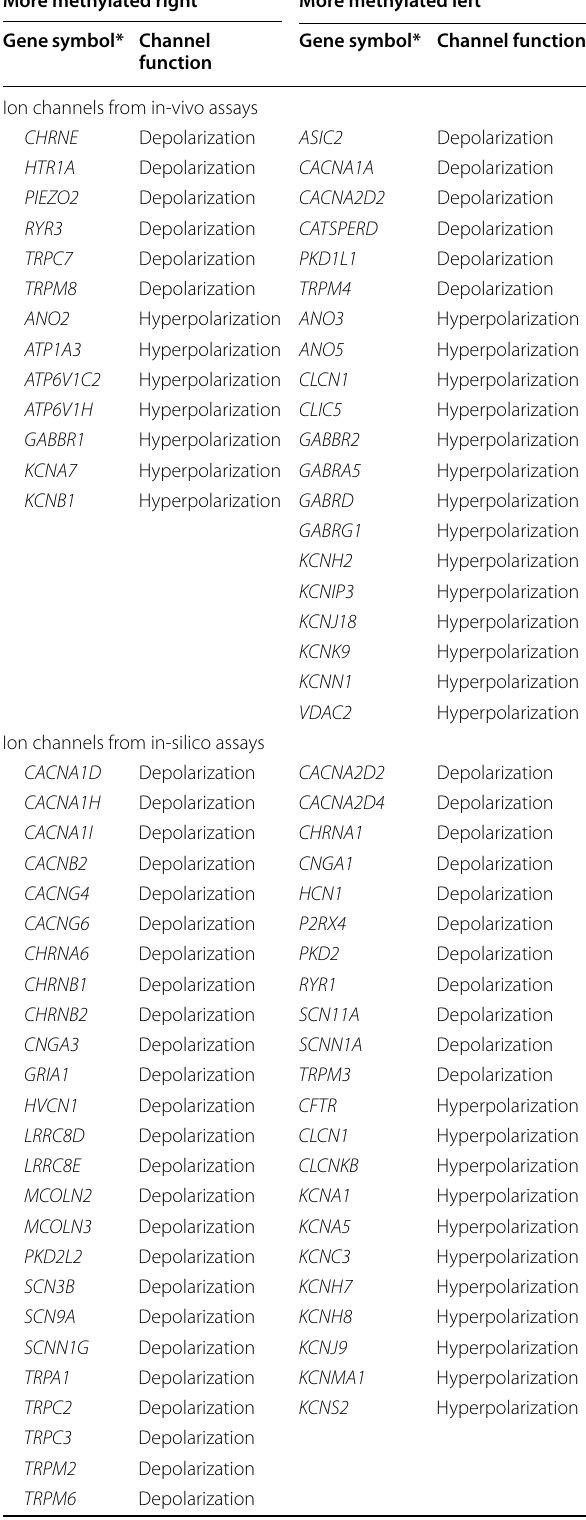
Table 1 L–R differential methylation of ion channels in in-vivo and in-silico